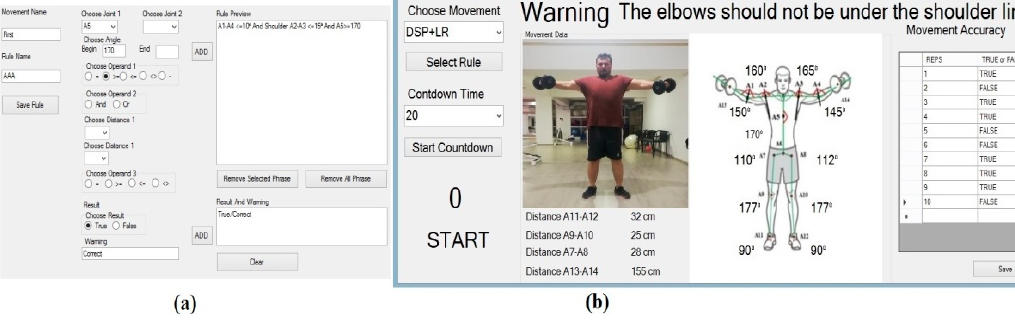
Figure 5. Expert System: ( a ) expert interface; ( b ) user interface.